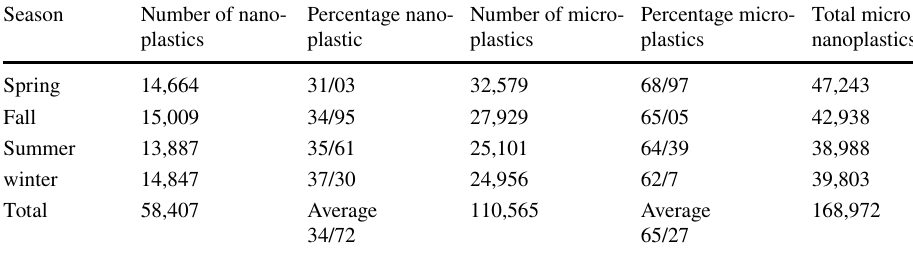
Season Number of nano-